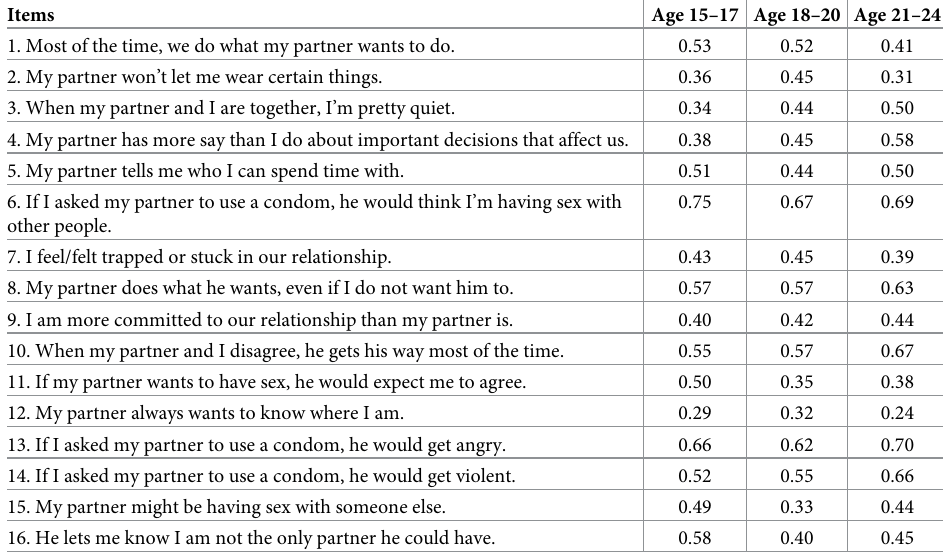
Table 3. Final factor loadings from the confirmatory factor analysis (CFA) for the Sexual Relationship Power Scale (SRPS) items (cid:3) .